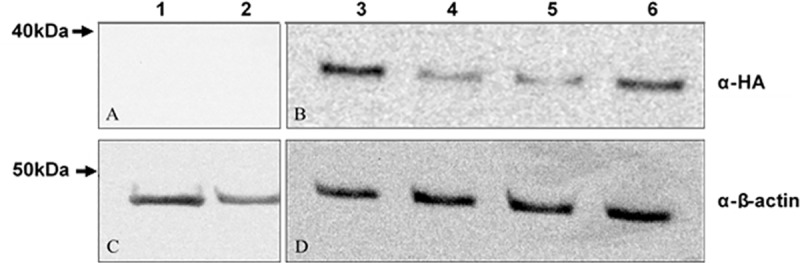
Western blots confirm expression of MagA in P19 cells.Lanes 1 and 2 contain protein extracted from untransfected parental P19 cells while lanes 3–6 contain protein from MagA-HA-expressing cells. Panels A and B were probed with antibody against HA. Panels C and D were probed with an antibody against the loading control, β-actin. Approximate M.W. is indicated on the left.